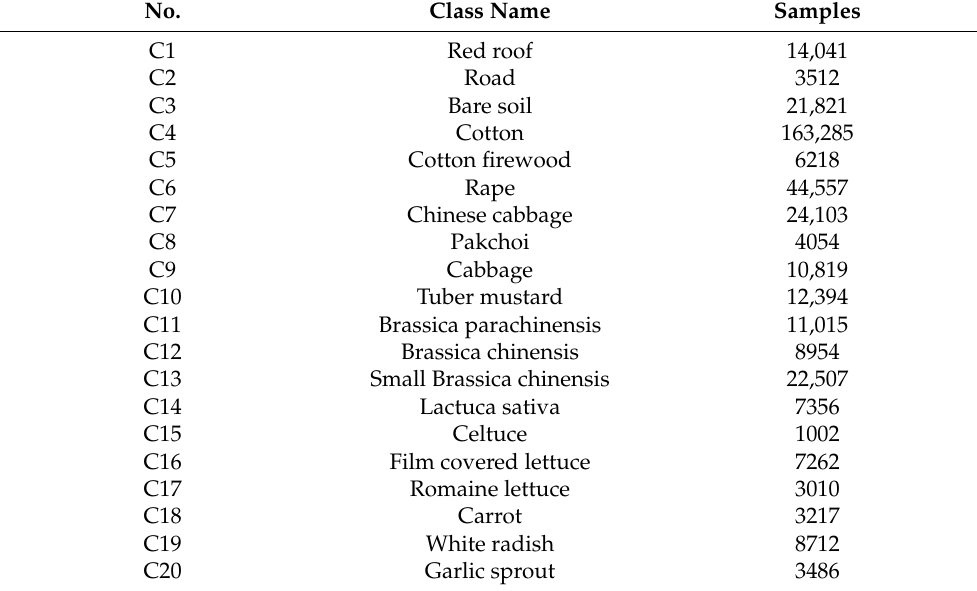
Table 3. Ground truth classes for the Honghu dataset and the corresponding sample number.